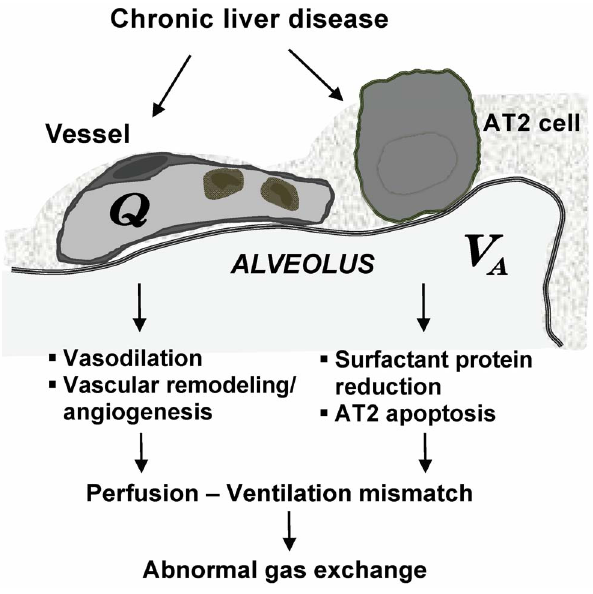
Figure 6. Current understanding of cellular mechanisms in the development of experimental hepatopulmonary syndrome. V A , alveolar ventilation; Q, alveolar blood